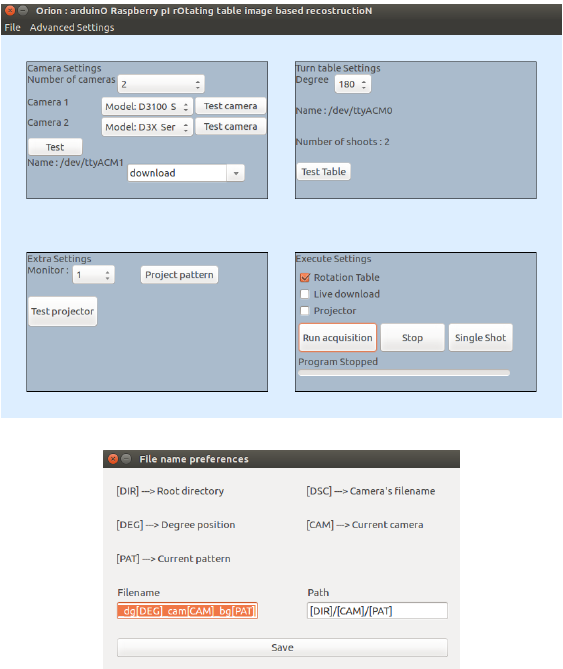
Figure 4. Current graphical user interface of ORION software application.